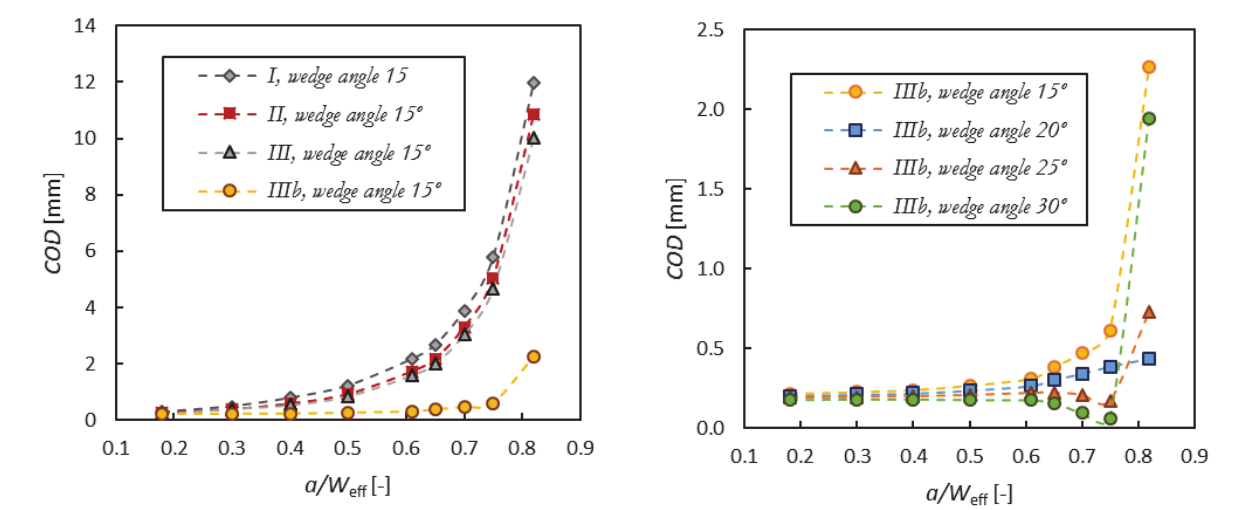
Figure 6 : COD as a function of the relative crack length, α , for WST and combined bending/splitting variants defined in Fig. 1 (as II, III and IIIb), loaded by P sp = 1000 N, on the left side for wedge angle =15° and on the right side for variant IIIb for various wedge